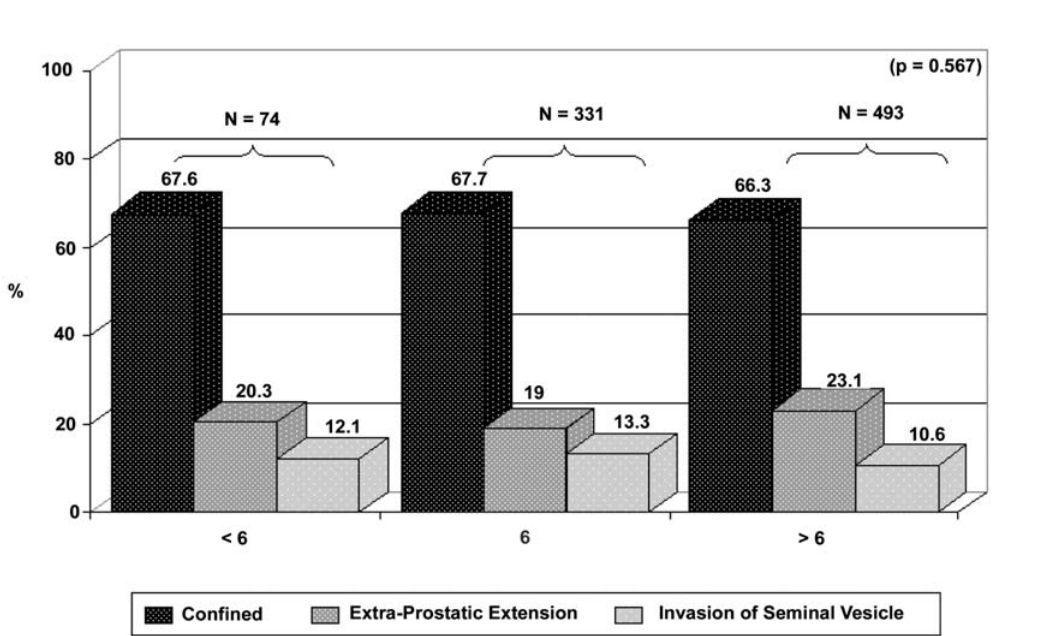
Figure 1 – Distribution of total number of collected fragments and distribution of lesions identified on